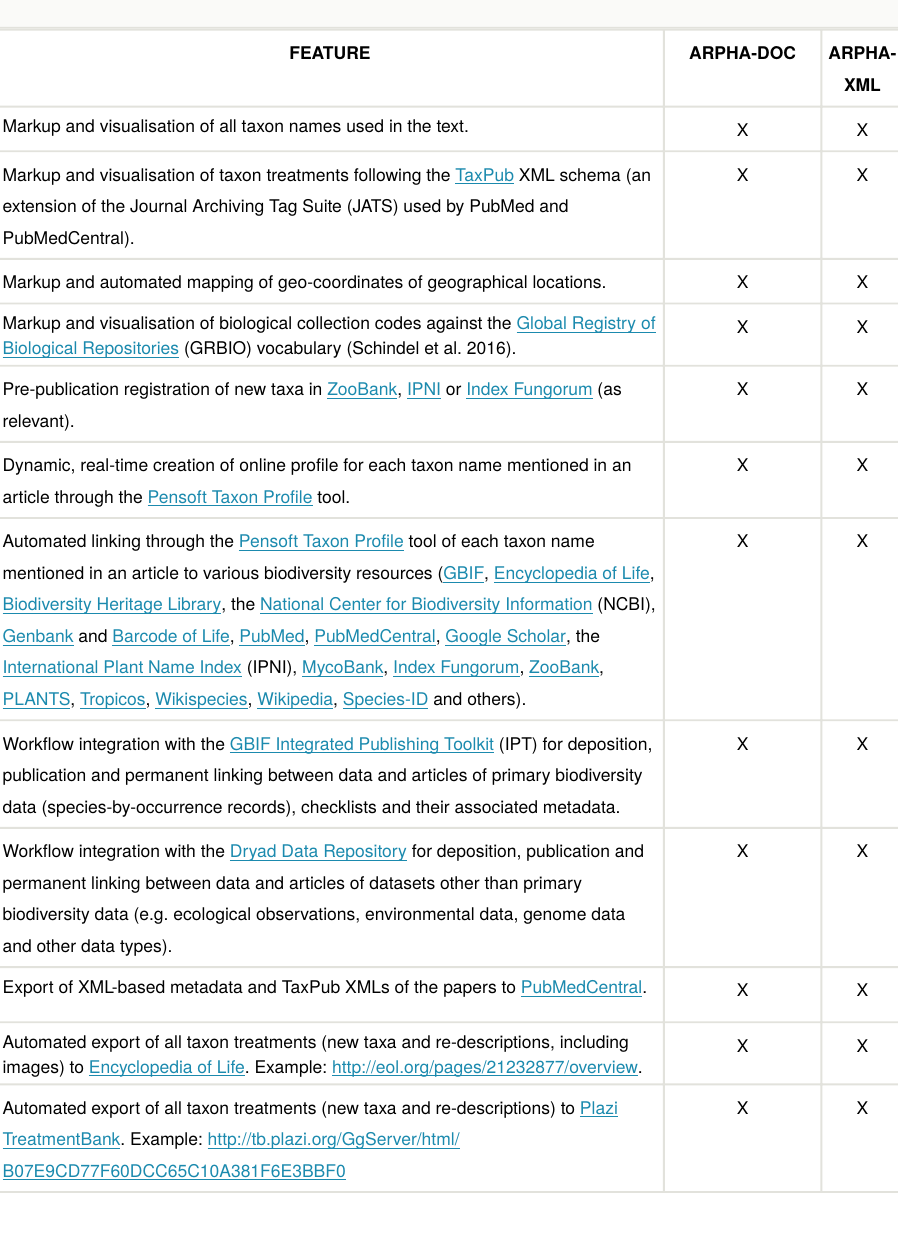
Table 2. Domain-speci fi c features of the ARPHA-BioDiv toolbox used for publication and dissemination of